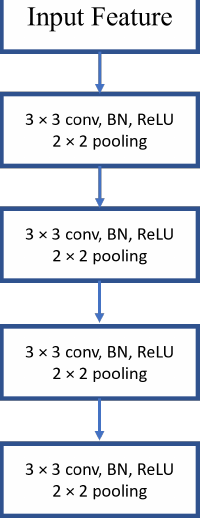
Figure 7. CNN Layer